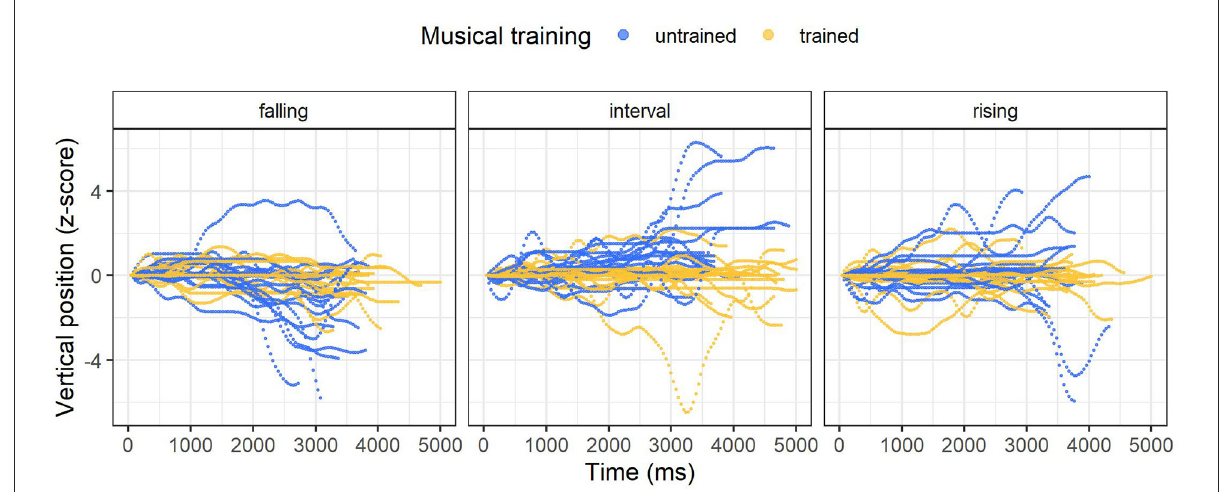
FIGURE1 Plot of the vertical head movement trajectories per melody type. Participants who can and cannot read staff notation are marked yellow and blue, respectively.